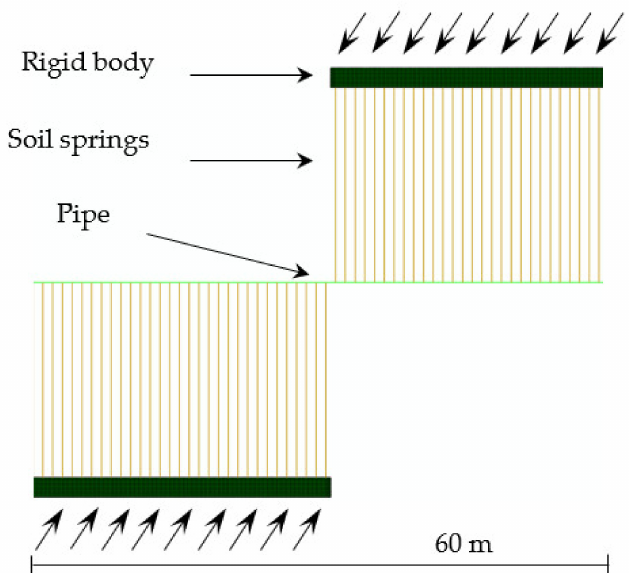
Figure 11. Beam–spring model for a buried steel pipeline subjected at a 60 ◦ strike-slip fault crossing with a length of 60